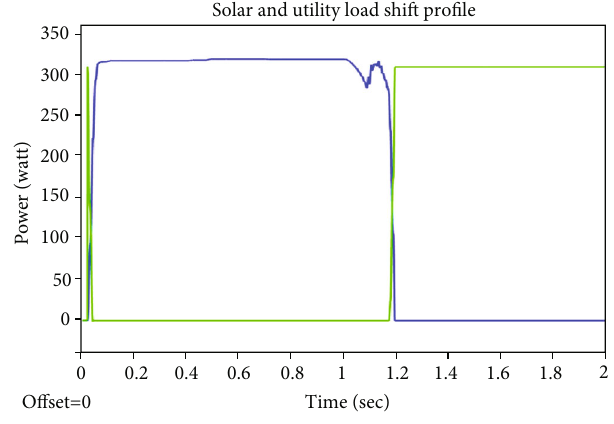
Figure 35: Basic load pro fi le of house 4.